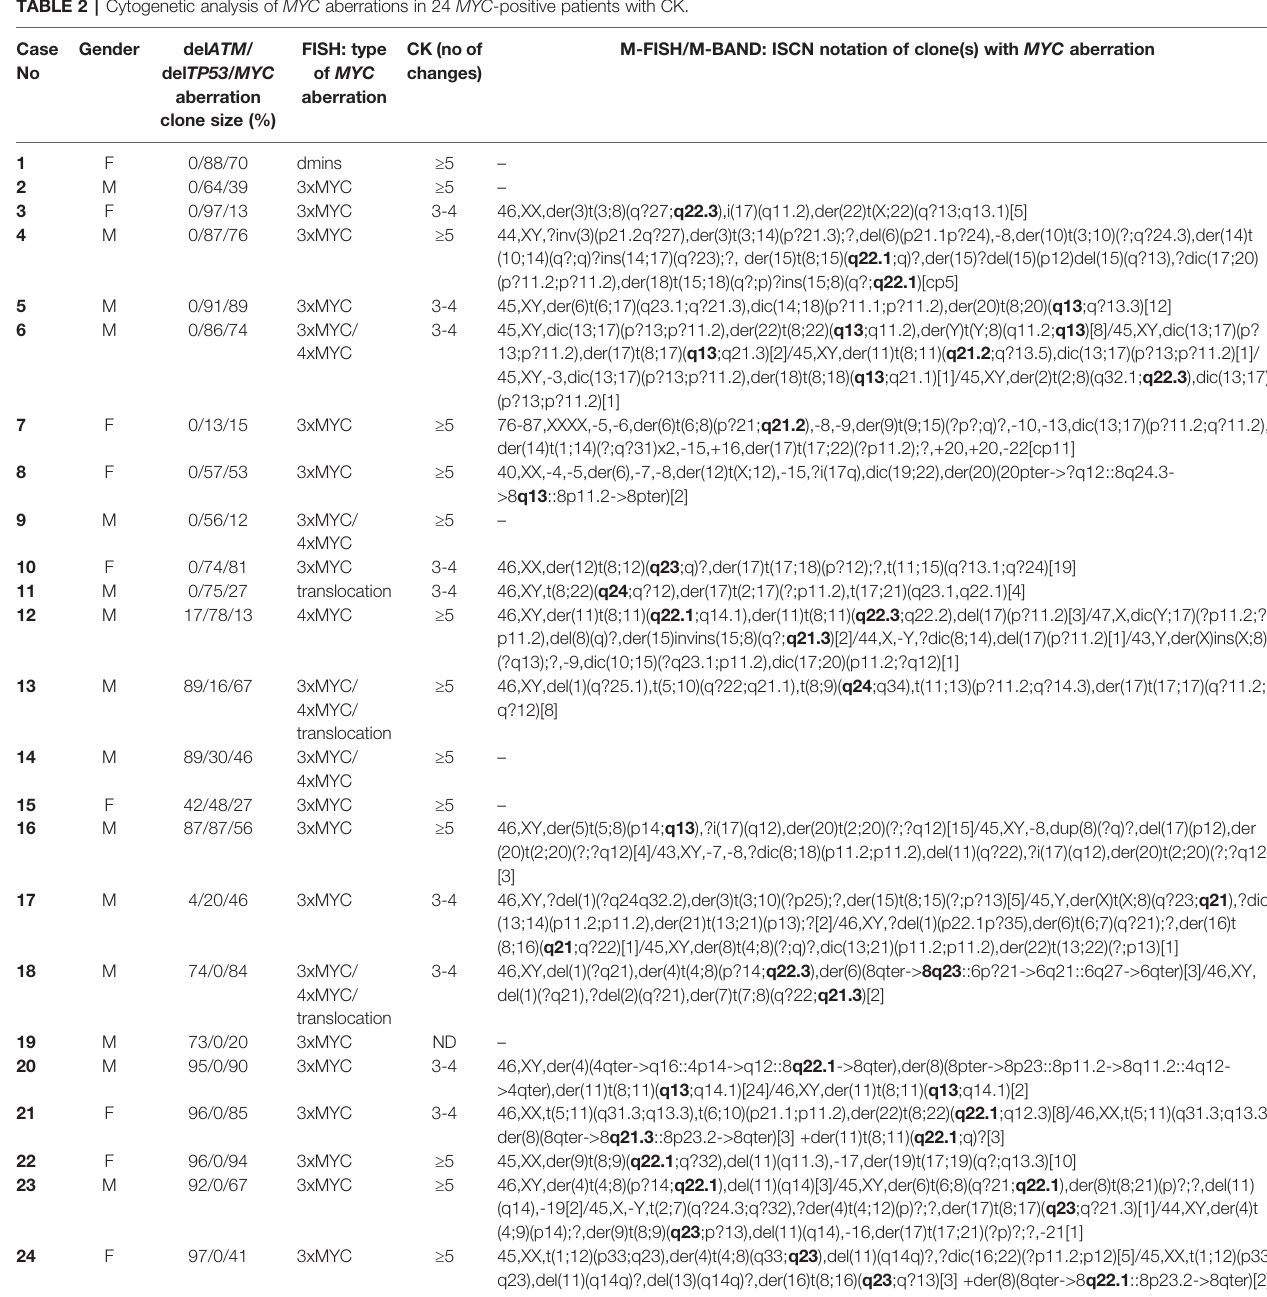
F, female; M, male; dmins, double minutes; CK, complex karyotype; M-FISH, multicolor FISH method; M-BAND, multicolor banding method. ND, not determined (the exact number of changesintheCKnot determinedasthedetailedanalysisbytheM-FISHmethodwasnot performed). ISCN,International SystemforHuman CytogenomicNomenclature. Thepositionof breaks on chromosome 8 is highlighted in